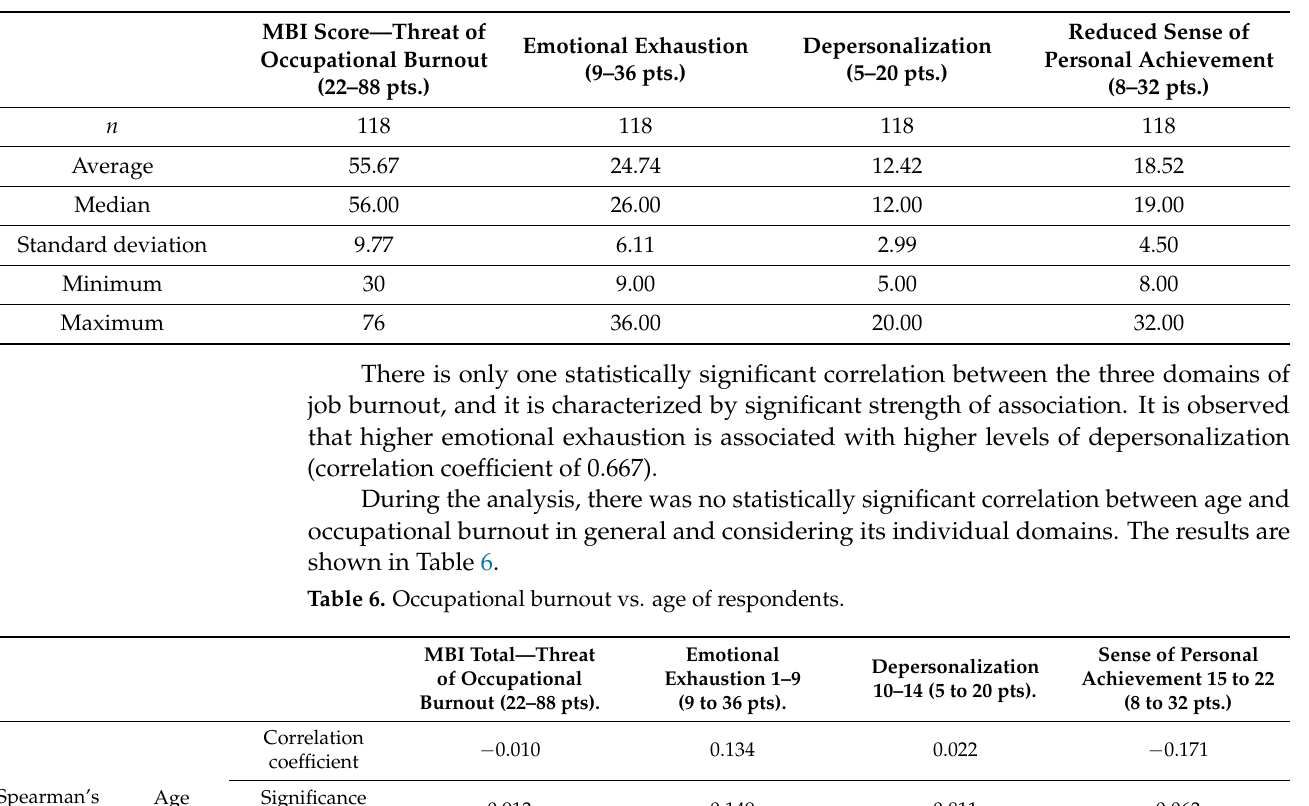
Table 5. MBI score—threat of occupational burnout.